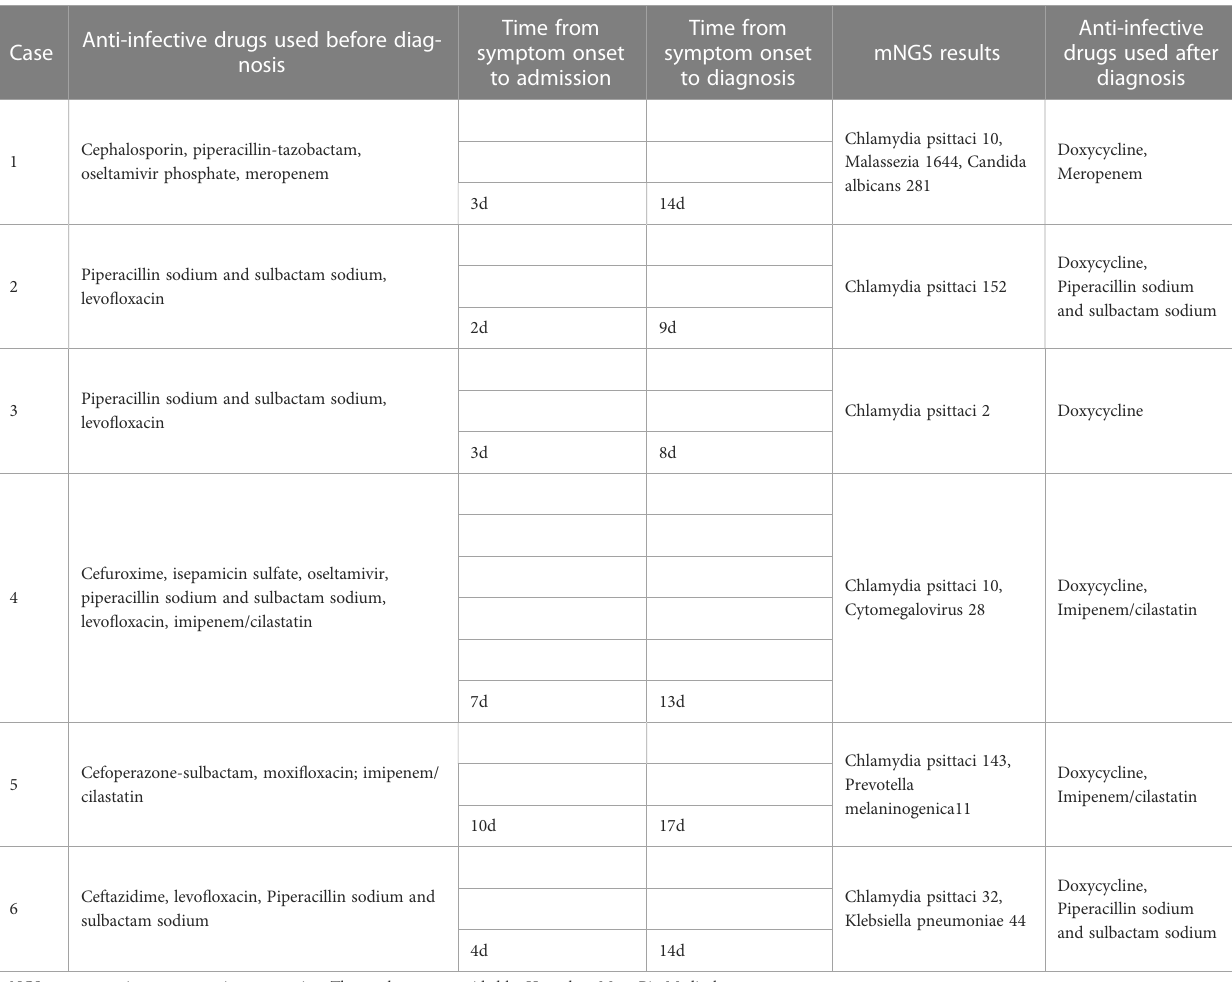
TABLE 3 Treatment and outcome of patients with Chlamydia psittaci